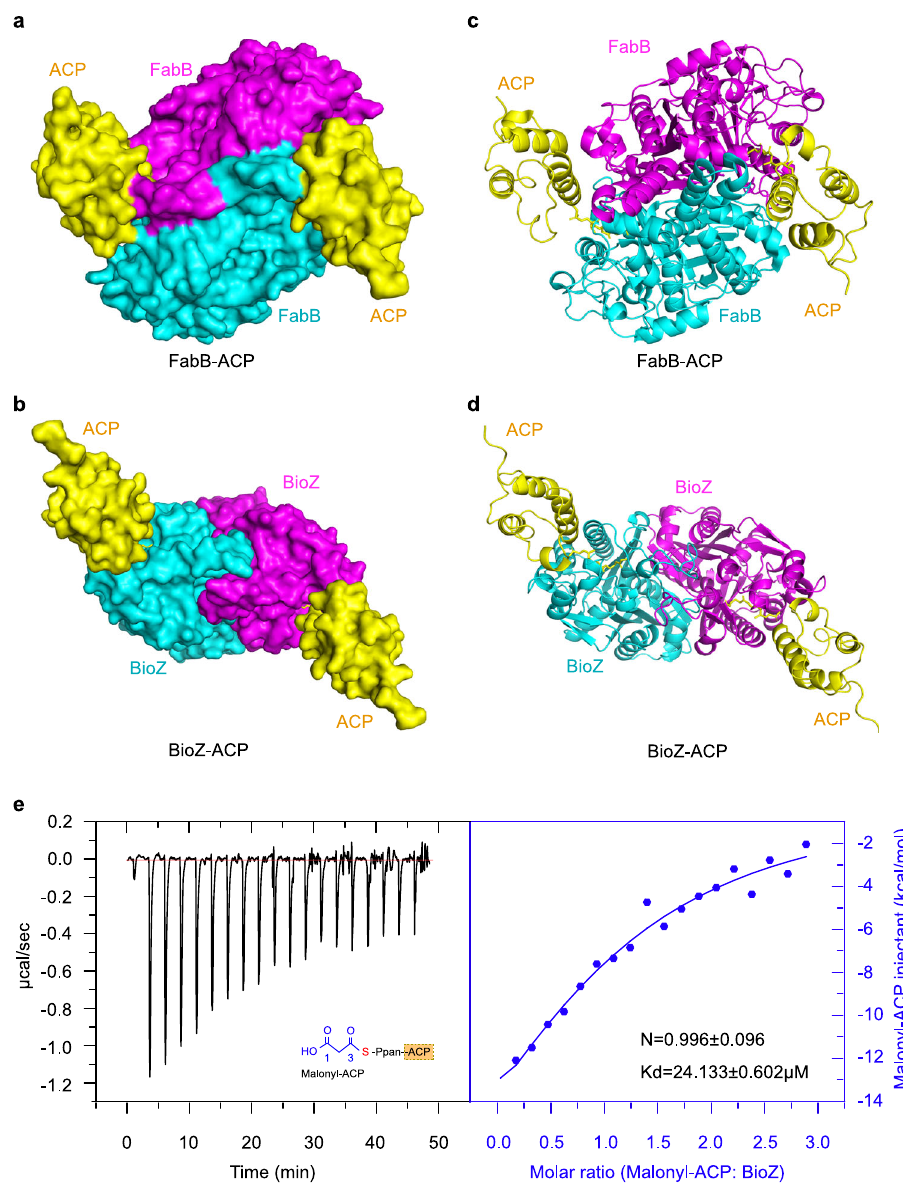
Fig. 6 Structural and functional analysis of BioZ binding to malonyl-ACP. Surface structure ( a ) and ribbon illustration ( c ) of the FabB dimer crosslinked with ACP. It was generated with PyMol using crystal structure of FabB-ACP (PDB: 5KOF). Surface structure ( b ) and ribbon illustration ( d ) of the dimeric BioZ complexed with malonyl-ACP. e Use of isothermal titration calorimetry (ITC) to probe the interaction between malonyl-ACP and BioZ. A representative result of ITC is shown, and the resultant stoichiometry values (N and Kd) from three independent experiments are given in an average ± SD. The putative binding mode of BioZ to its substrate malonyl-ACP (and/or glutaryl-ACP) was generated through structural superposition. The stoichiometry (malonyl-ACP: BioZ) is 1:1, in that the molar ratio was measured to be ~0.996. The parameter of binding af fi nity (Kd) is 24.133 ± 0.602 μ Unlike that the FabB substrate-binding pocket whose entrance is close to the dimeric interface (Fig. 6a, c), the entrance of the AtBioZ substrate-binding pocket is relatively far away from the dimeric interface (Fig. 6b, d). In the case of FabB-ACP (Supplementary Fig. 19a-b), the ACP protein mainly interacts with one monomer while the acyl group on ACP inserts into the substrate-binding pocket of another monomer (Fig. 6a, c). In other words, both monomers of the FabB dimer cooperate for ACP protein and acyl group binding. The ClusPro-based molecular docking identi fi ed a putative interface between BioZ with its cognate ACP (Supplementary Figs. 18a and 19c, d). In contrast to its relatively weak af fi nity with ACP alone having the stoichio- metry (N = 1.00 ± 0.17, Kd = 0.33 ± 0.25 mM, in Supplementary